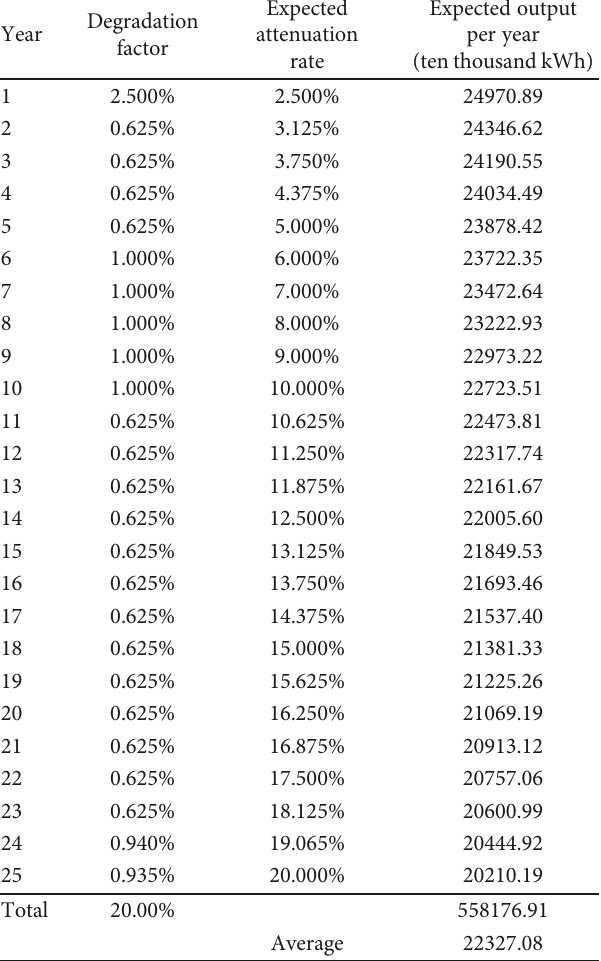
Figure 11: Expected output capacity generation 25 years.